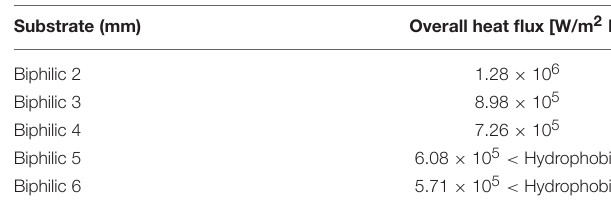
TABLE 2 | The overall heat flux through the condenser surface for 2, 3, 4, 5, and 6mm biphilic